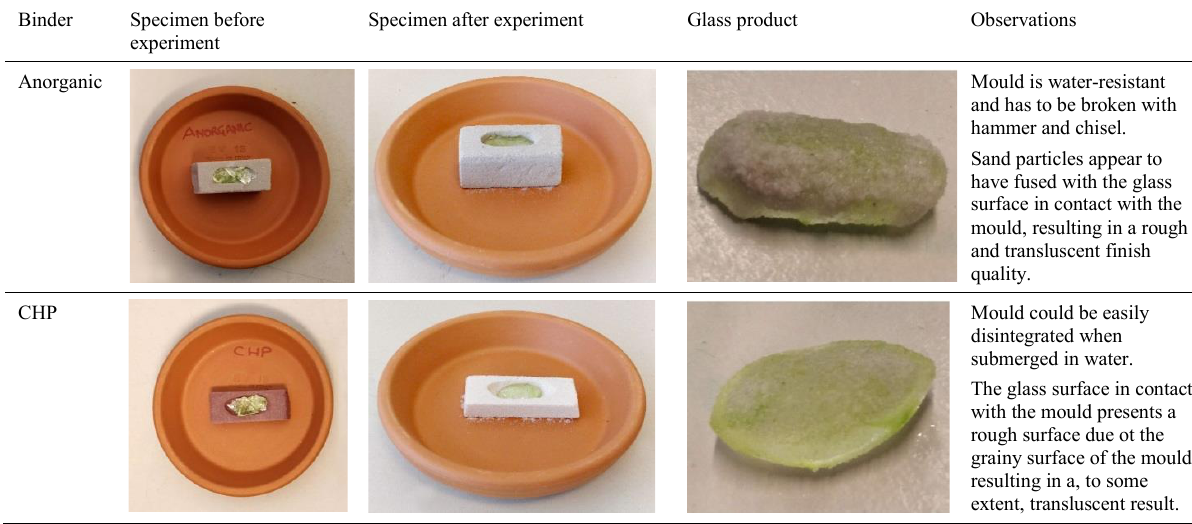
Table 4: Results of 2 nd Test